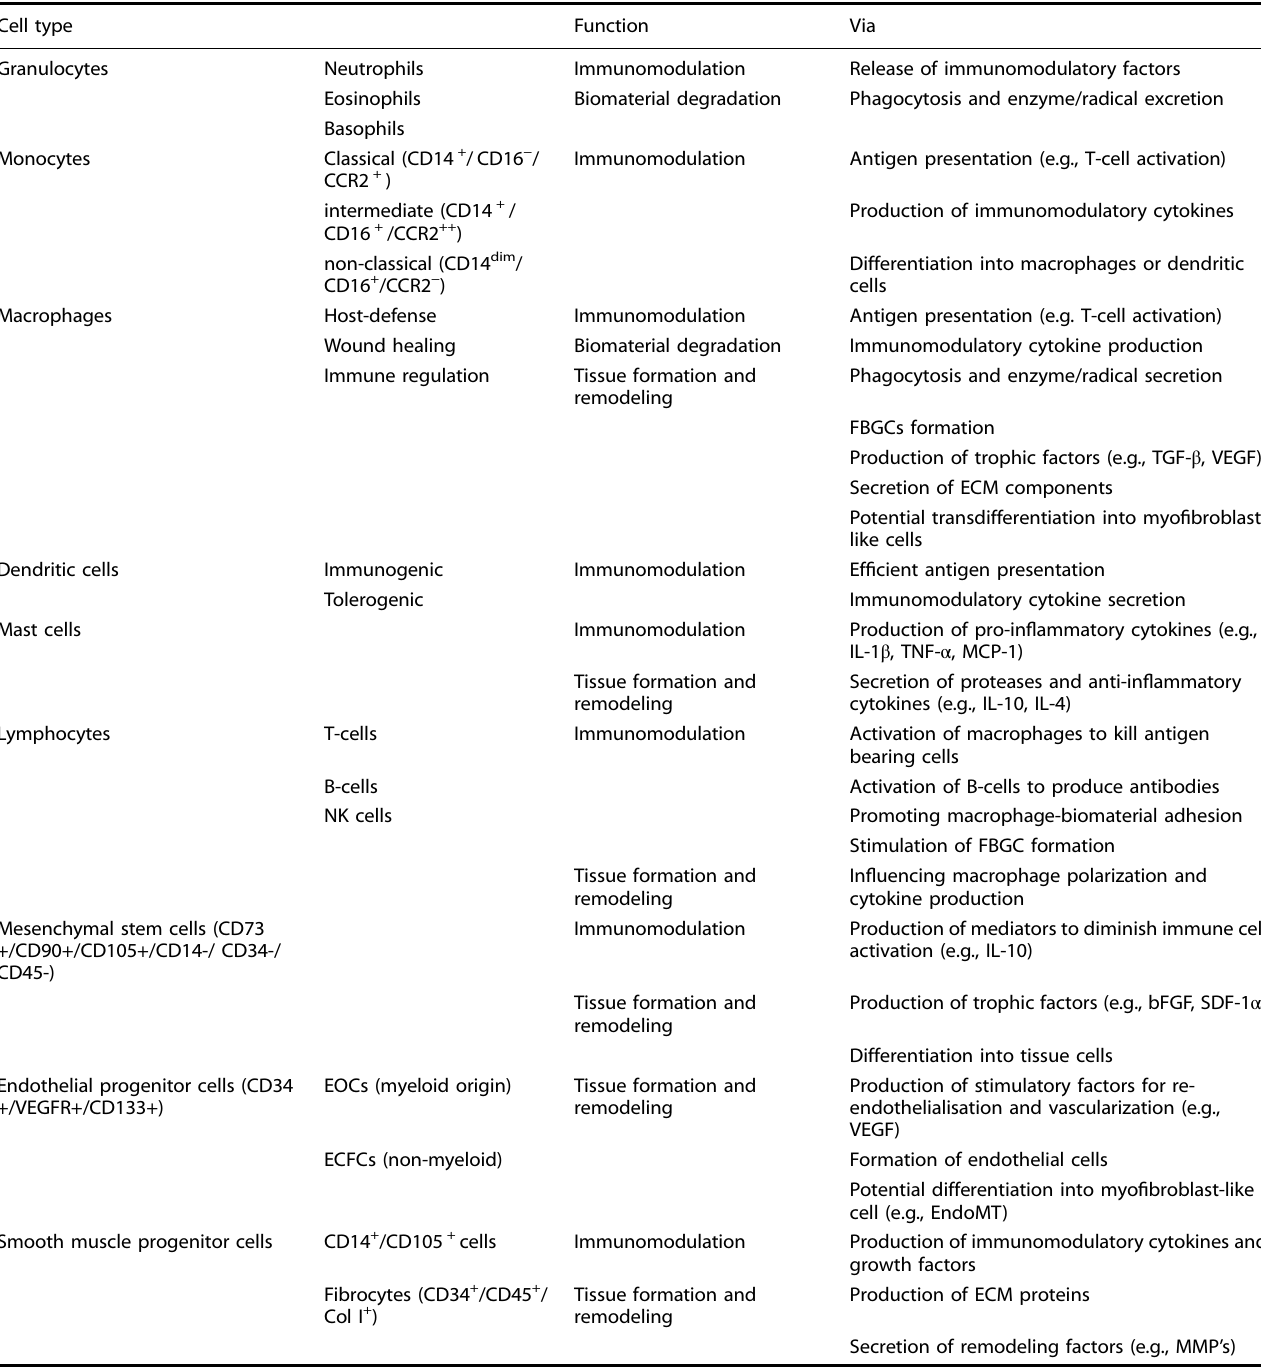
Table 2. Overview of cell types involved in in situ TE and their proposed